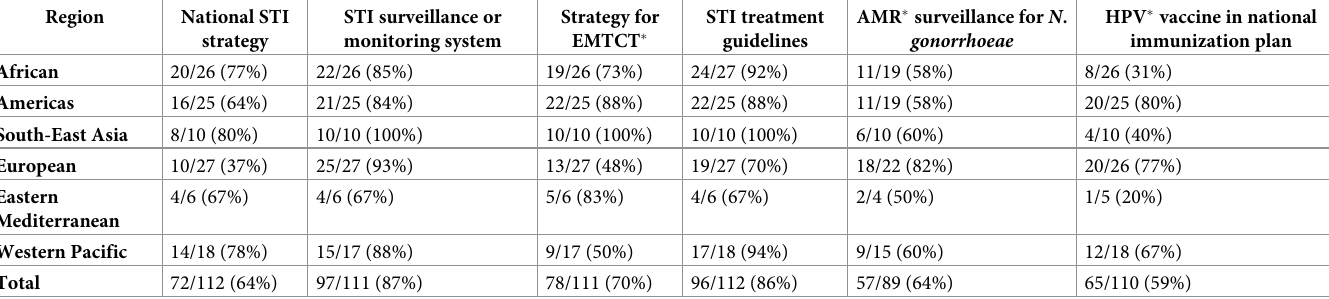
Table 1. National policies and guidelines for STI surveillance and programming by WHO Region. Region National STI